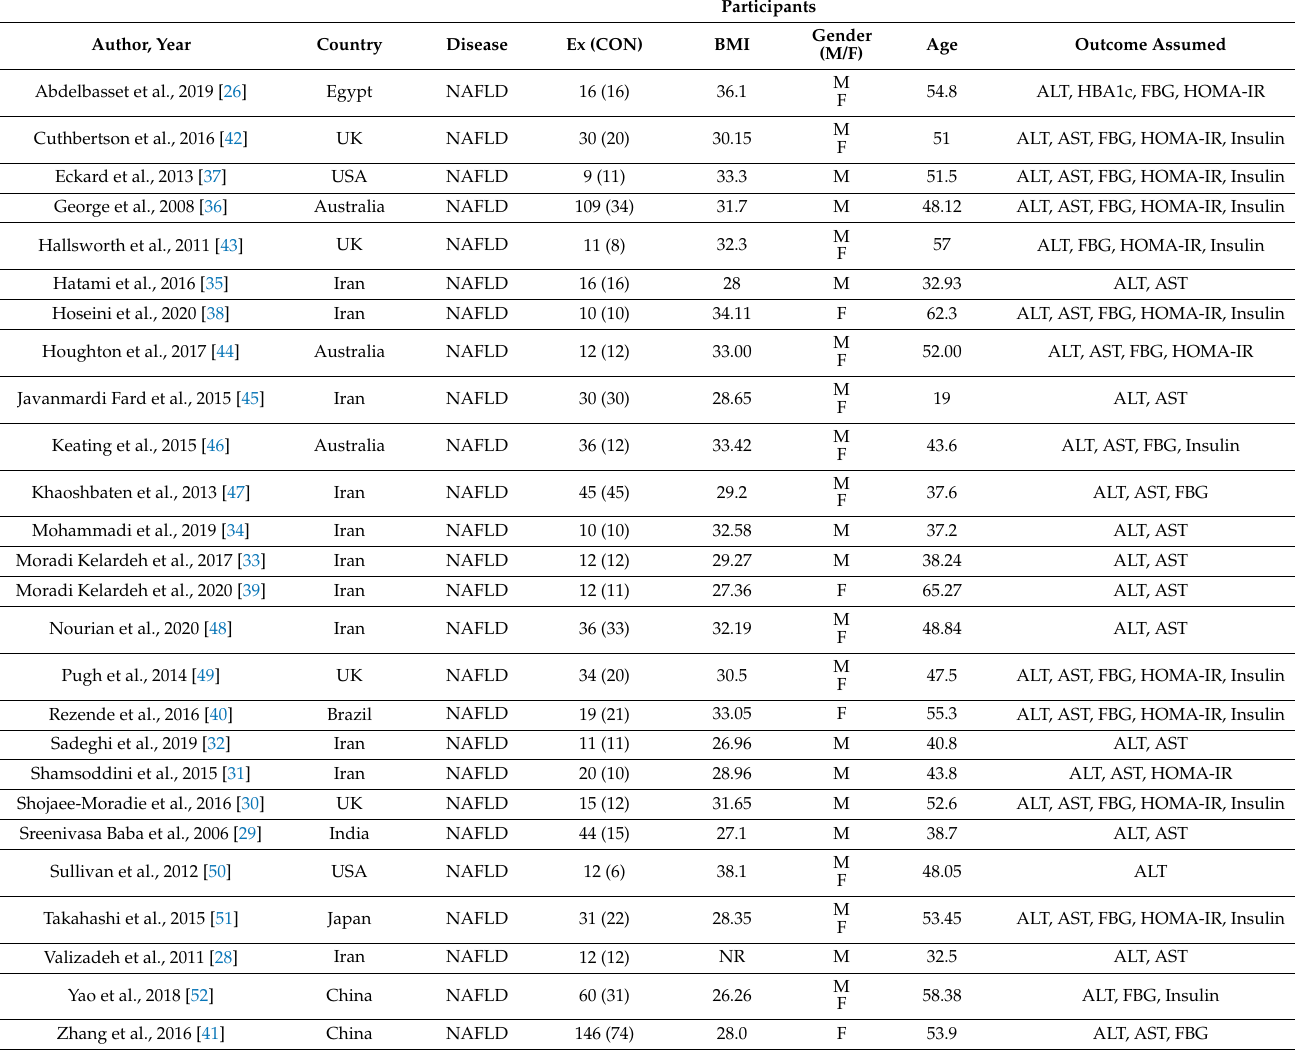
Table 1. Characteristics of the included